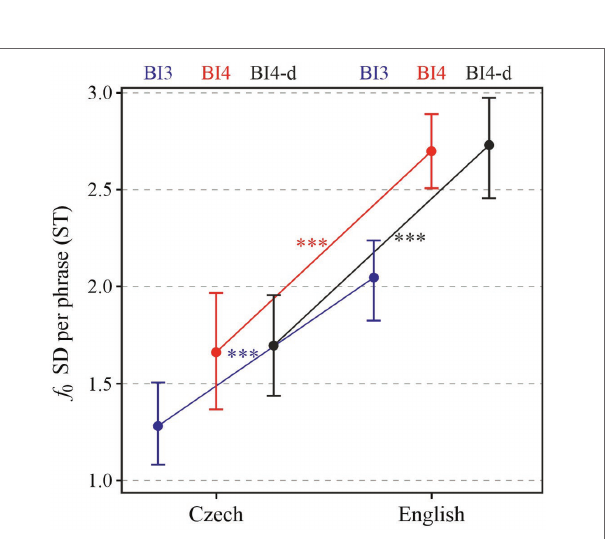
FIGURE 5 | Standard deviation of f 0 in each prosodic phrase depending on L anguage and P rosodic break type (BI3 in blue, BI4 in red, and BI4-d in black). *** p <